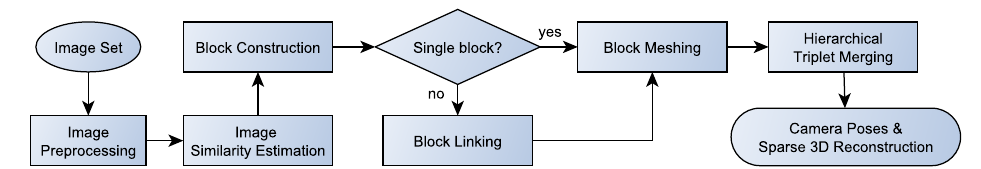
Figure 2. Wide Baseline Structure from Motion